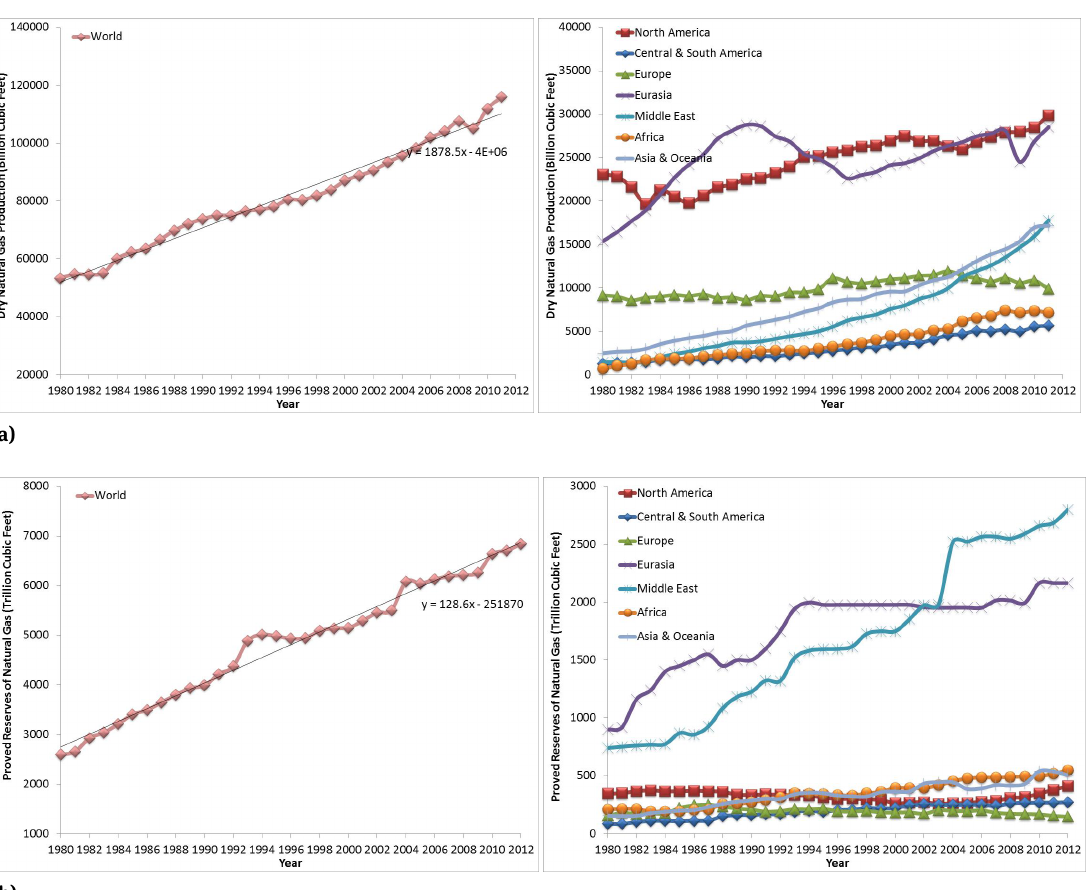
Fig. 2. (a) Natural gas production according to the U.S. Energy Information Administration [35]. www.eia.gov/cfapps/ipdbproject/ iedindex3.cfm?tid=3&pid=26&aid=1&cid=regions&syid=1980&eyid=2012&unit=BCF (b) Natural gas proved reserves according to the U.S. Energy Information Administration [35]. www.eia.gov/cfapps/ipdbproject/iedindex3.